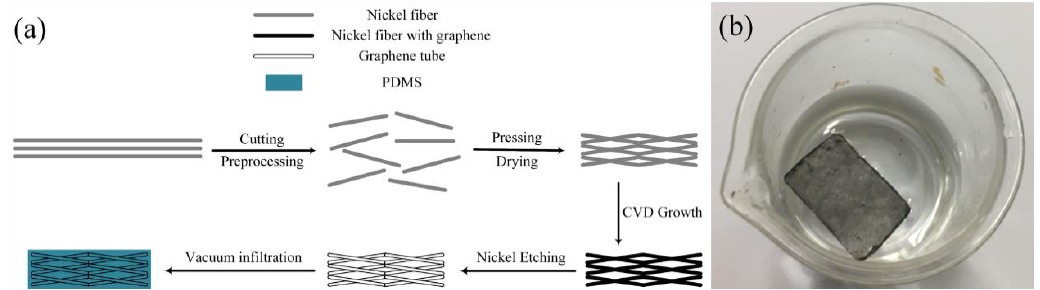
Figure 1. ( a ) Preparation process of porous polydimethylsiloxane/graphene network (PDMS/GN) nanocomposite; ( b ) prepared PDMS/GN floating on water.